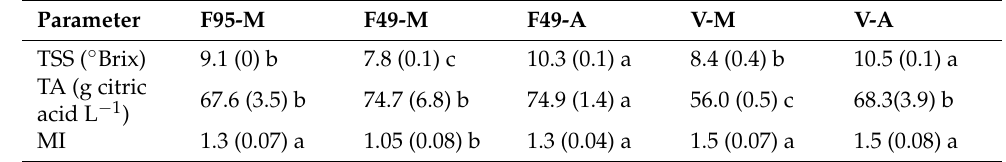
Table 4. Variations of total soluble solids (TSS), titratable acidity (TA) and maturity index (MI) of lemons (“Fino 95”, “Fino 49” and “Verna”) obtained in different rootstocks ( C. macrophylla and C. aurantium ). The values represented are the mean with their standard deviation in parentheses.